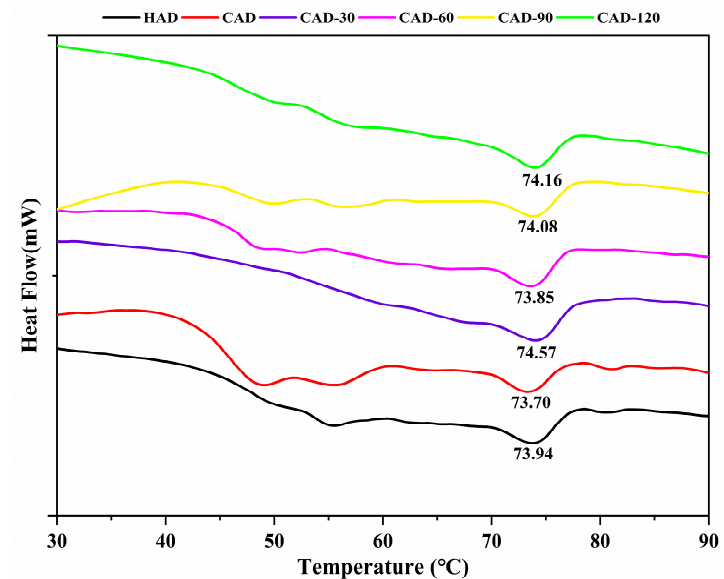
Figure 6. Di ff erential scanning calorimetry of semi-dried pu ff er fi sh fi llets under di ff erent drying methods. F, fresh, undried fillets; HAD, hot air drying; CAD, cold air drying; CAD-30, cold air drying for 30 min; CAD-60, cold air drying for 60 min; CAD-90, cold air drying for 90 min; CAD-120, cold air drying for 120